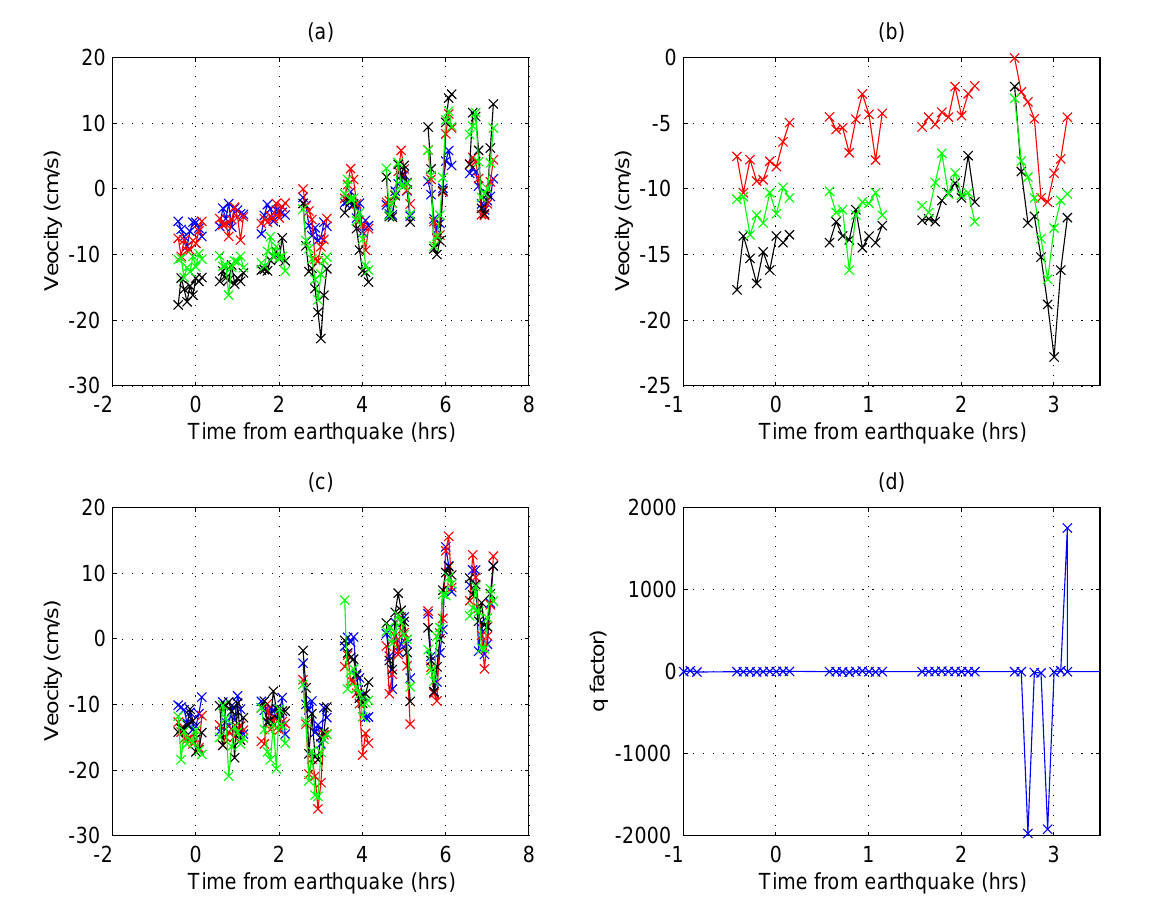
Figure 6. Time series of velocity components from TOKU. ( a , b ): Blue: 0–2 km; Red: 2–4 km; Black: 4–6 km; Green 6–8 km (a) over 10 h (b) around the tsunami arrival time ( c ) Blue: 8–10 km; Red: 10–12 km; Black: 12–14 km; Green 14–16 km. ( d ) q-factor for 2–8 km